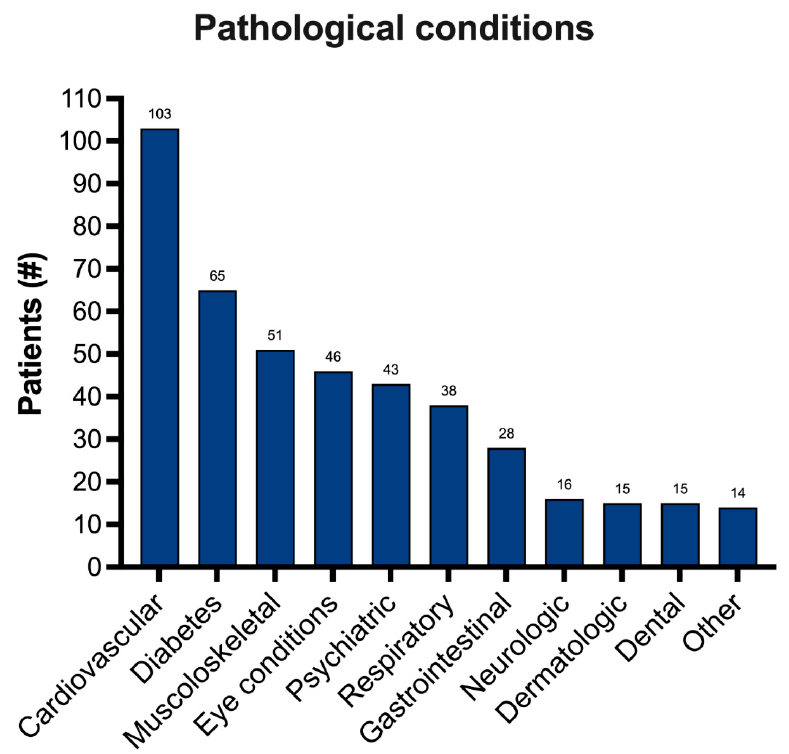
Figure 2. The most common pathological conditions found in our